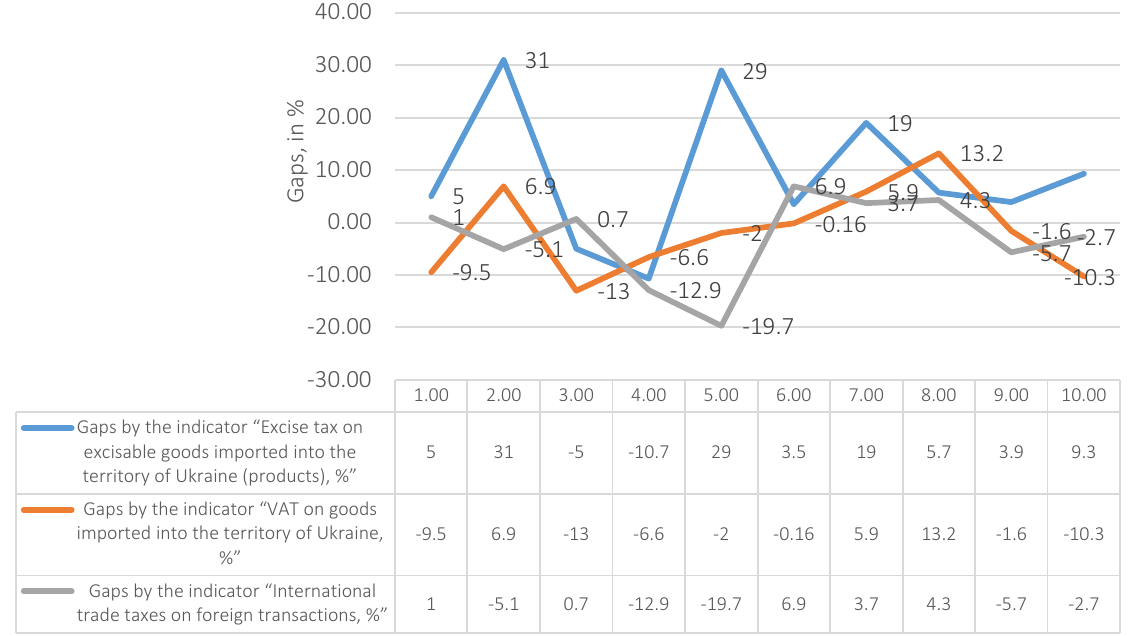
Figure 2. Gaps in customs revenues to the consolidated budget,